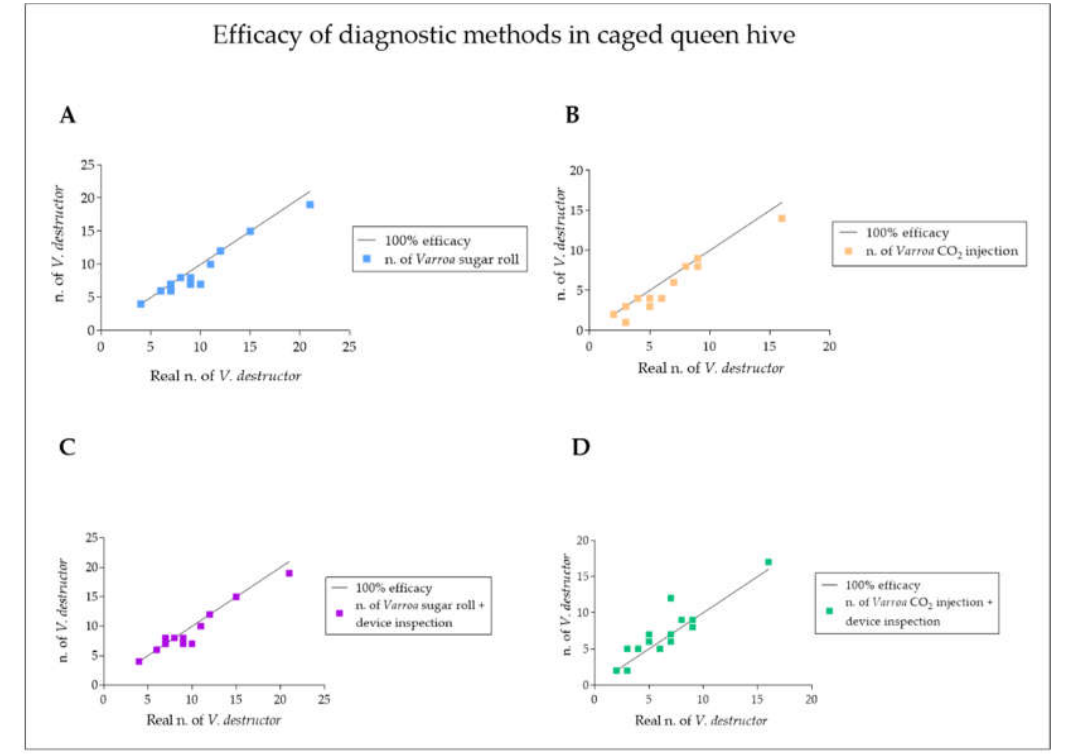
Figure 6. The panel reports the degree of efficacy of the diagnostic methods used to analyze caged queen hive samples of Apis mellifera ligustica . The graphs show the number of V. destructor counted with sugar roll test ( A ), CO 2 injection ( B ), sugar roll test and device inspection ( C ) and CO 2 injection and device inspection ( D ), as a function of their real number in bee samples ( V. destructor collected via the tested method added to those collected after washing the sample). Each point represents a measurement. The points on the black line represent an efficiency of the measurement method of 100%.